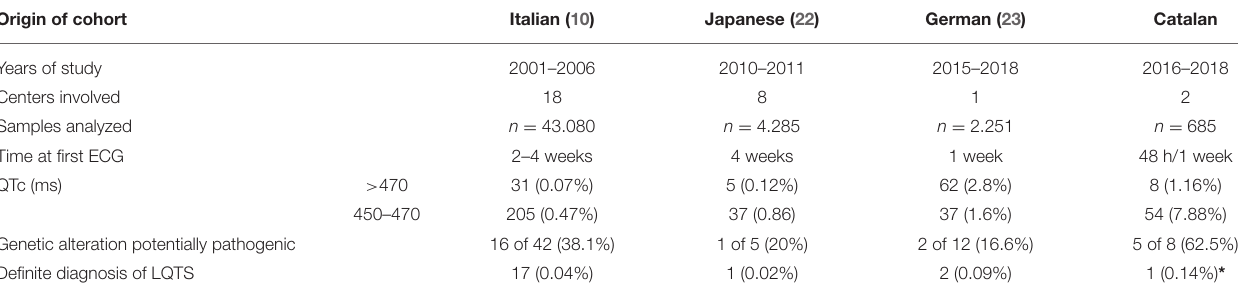
TABLE 1 | QTc intervals in similar